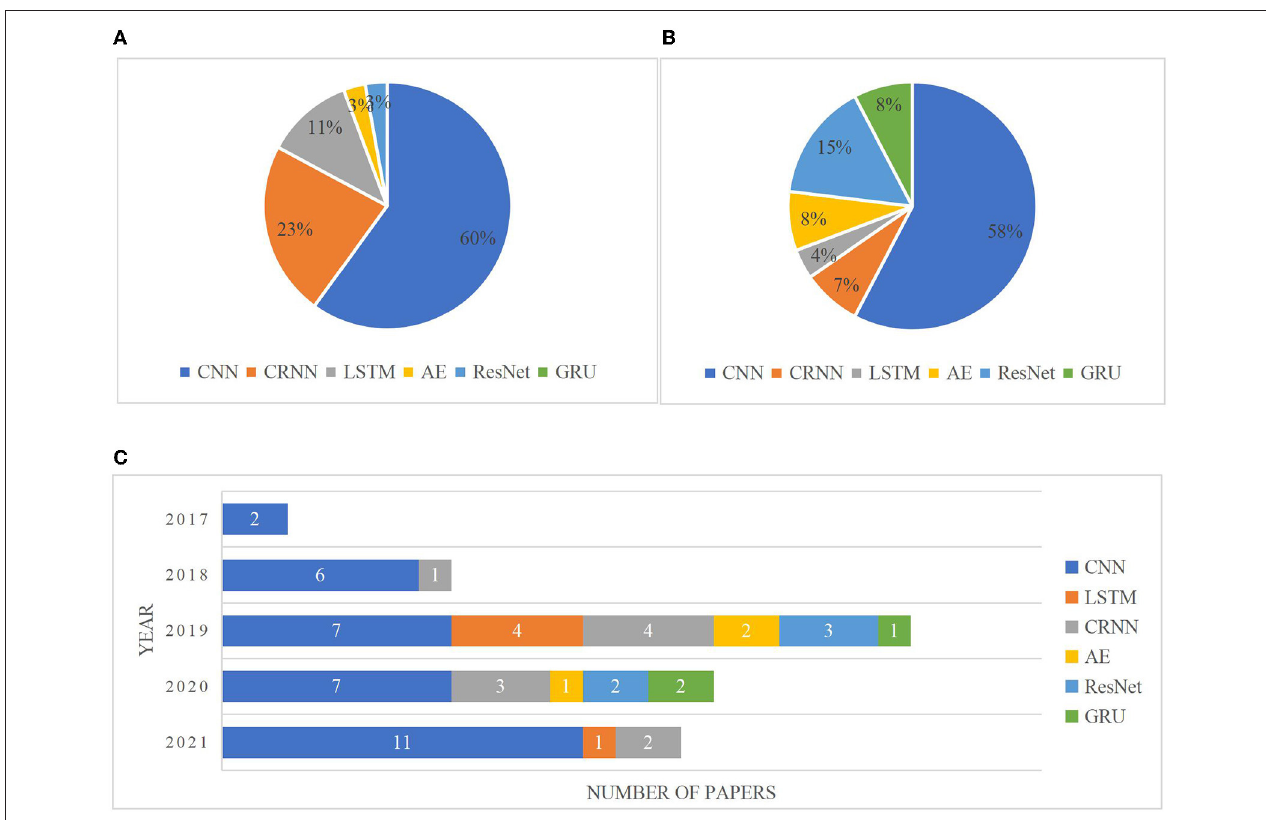
FIGURE 5 | Percentages on different deep learning (DL)-based models for MI detection (A) and localization (B) . Convolutional neural network (CNN) is the most common technique used for both MI detection (with 60% contribution) and localization (with 58% contribution). Convolutional recurrent neural network (CRNN) (for MI detection) and ResNet (for MI localization) are the next most frequently used learning techniques in articles. Distribution of articles focused on each DL method in recent 5 years (C) . This figure shows the usage changes over the years of the six methods. Another four types of DL methods have been emerged for MI diagnoses from 2019 compared to that in 2018, while only CNN and CRNN were used in 2017 and 2018. CNN dominated the model categories in each year, and the proportion of CNN shows a gradual upward trend from 2019 to 2021 (33, 47, and 79 in 2019, 2020, and 2021,